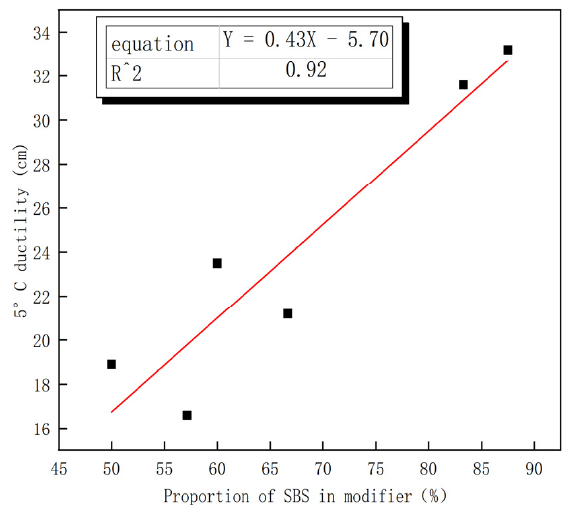
Figure 3. Relationship between ER content and low temperature ductility.